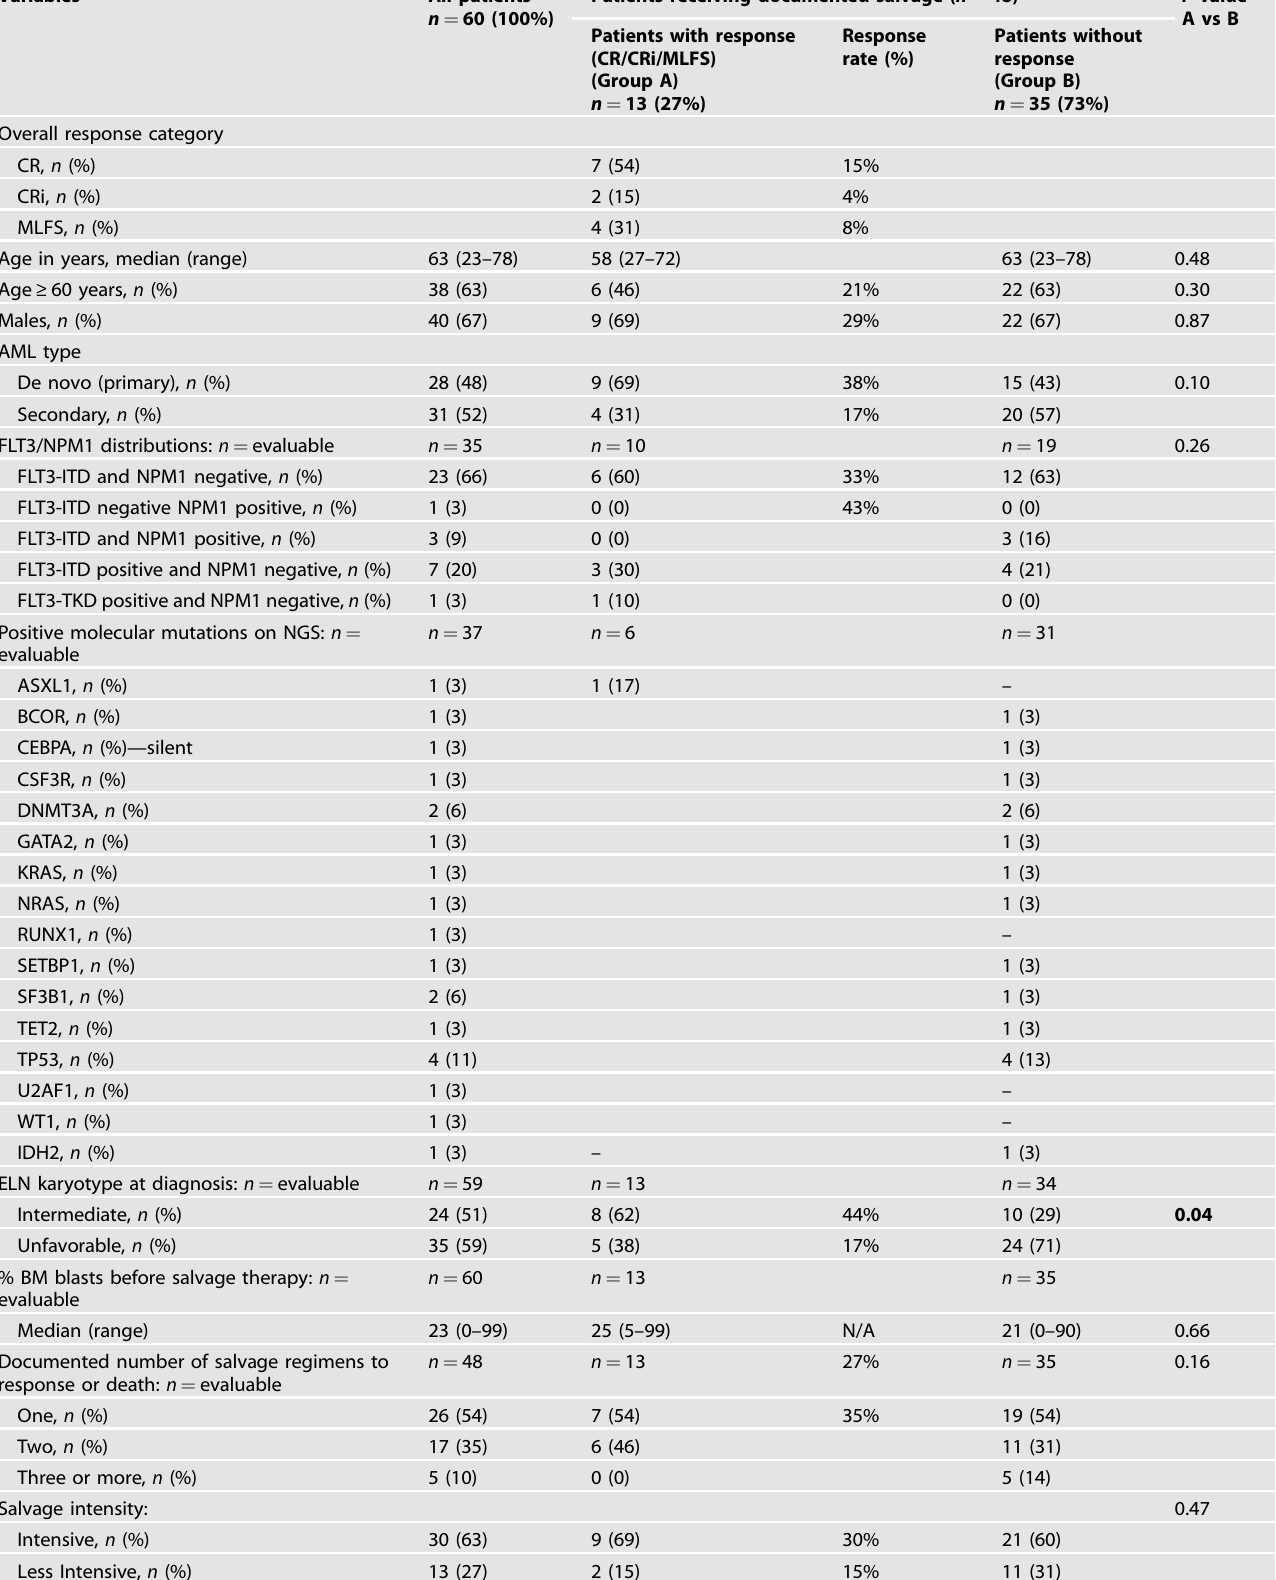
Table 1. Clinical characteristics of 60 patients with European LeukemiaNet-de fi ned primary refractory acute myeloid leukemia (AML), strati fi ed by the achievement of response after documented salvage